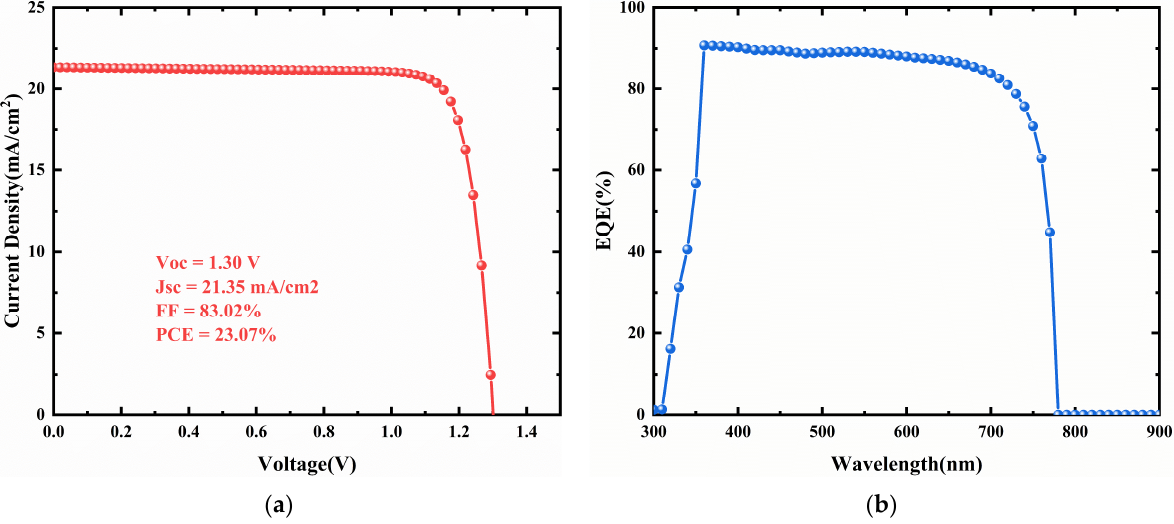
Figure 19. ( a ) J-V curve for the optimized device with FTO/TiO 2 /CCSCNCs/Cu 2 O/Au structure; ( b ) EQE curve for the optimized device with FTO/TiO 2 /CCSCNCs/Cu 2 O/Au structure.